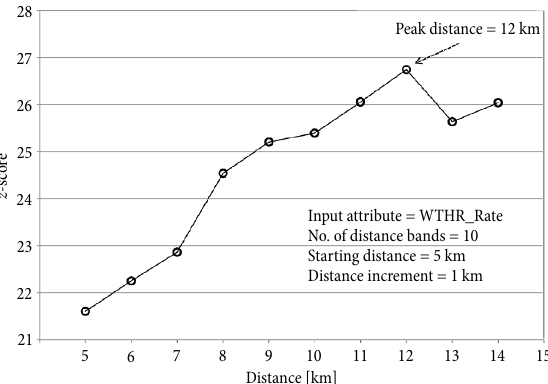
Input attribute = WTHR_Rate No. of distance bands = 10 Starting distance = 5 km Distance increment =